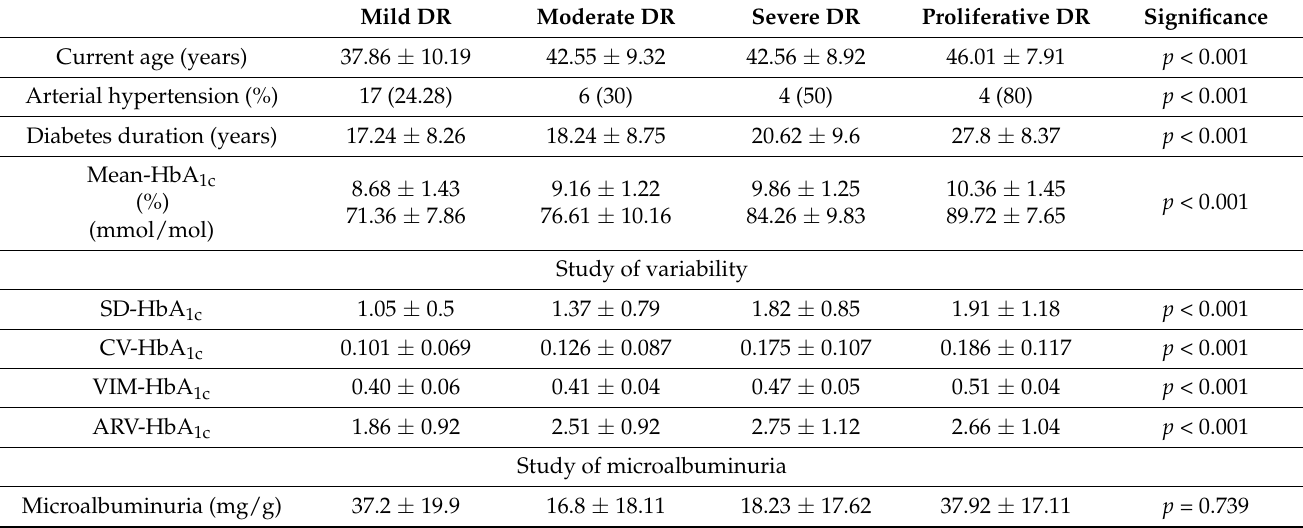
Table 2. Differences in severity of diabetic retinopathy with significant variables and microalbuminuria. Mild DR Moderate DR